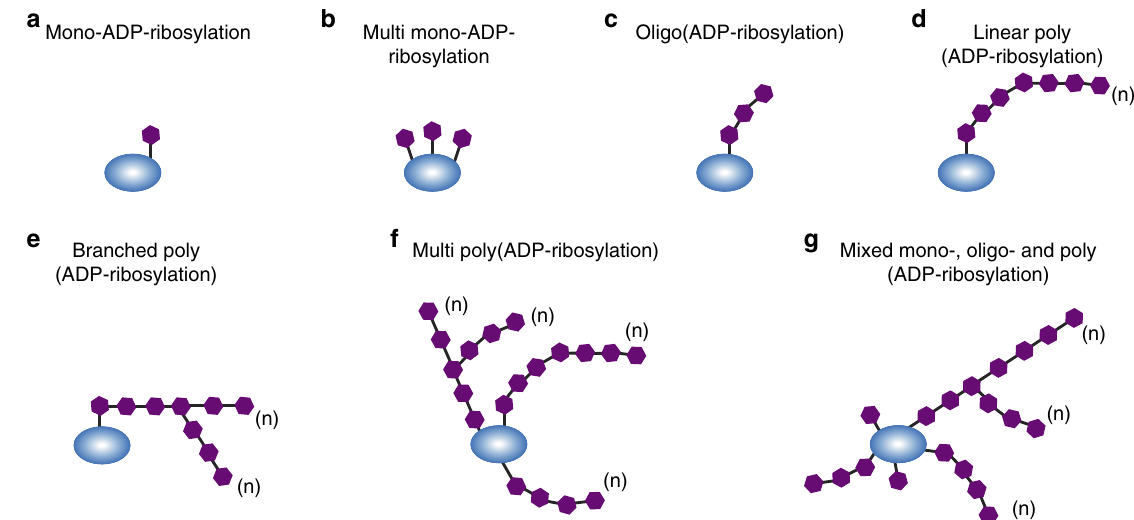
Fig. 1 Possible patterns of ADP-ribosylation on target proteins. a Mono-ADP-ribosylation; a single ADP-ribose molecule is attached to the protein. b Multi mono-ADP-ribosylation; multiple single ADP-ribose units are bound along the protein. c Oligo(ADP-ribosylation); short linear chains of ADP-ribose are transferred to the protein. d Linear poly(ADP-ribosylation); ADP-ribose moieties forming a long linear chain up to 200 units in length. e Branched poly (ADP-ribosylation); complex molecules composed of large and branched polymers of ADP-ribose. f Multi poly(ADP-ribosylation); multiple PAR chains either linear or branched on the same protein. g Mixed ADP-ribosylation; a mixture of the previously described ADP-ribose patterns on the same protein, generated either by the combined action of MAR- and PAR transferases or by the degradative action of